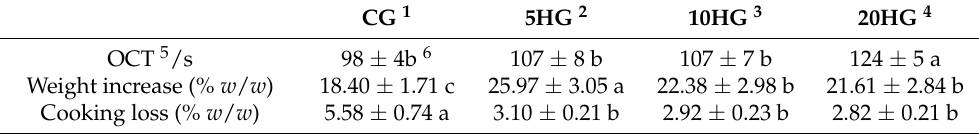
Table 4. Cooking quality parameters of control and hemp seed flour-enriched gnocchi